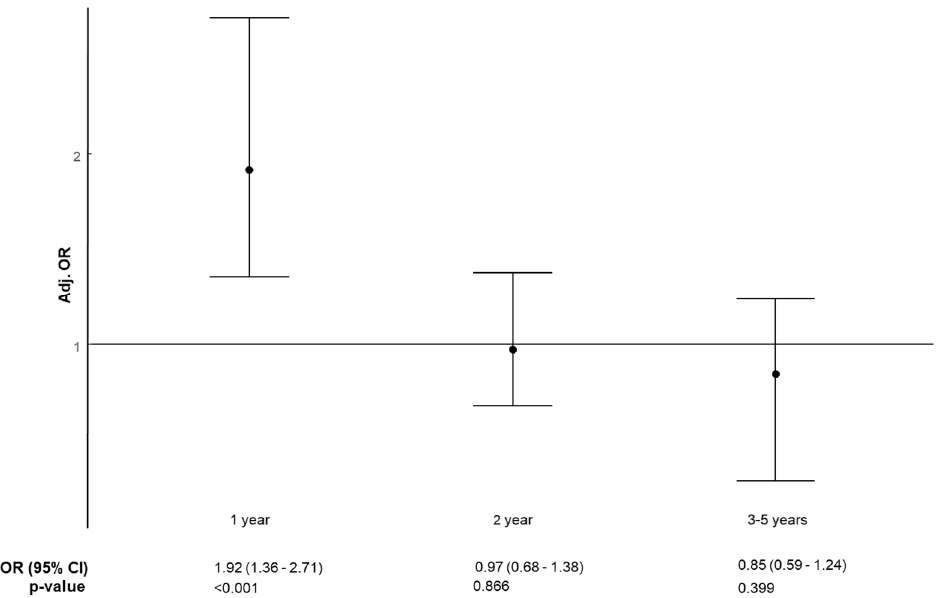
Figure 2. Forest plot showing the influence of previous antibiotic use in the past 5 years on the decay of resistance to third generation cephalosporins (3GCs) of E. coli over time (multivariate analysis).